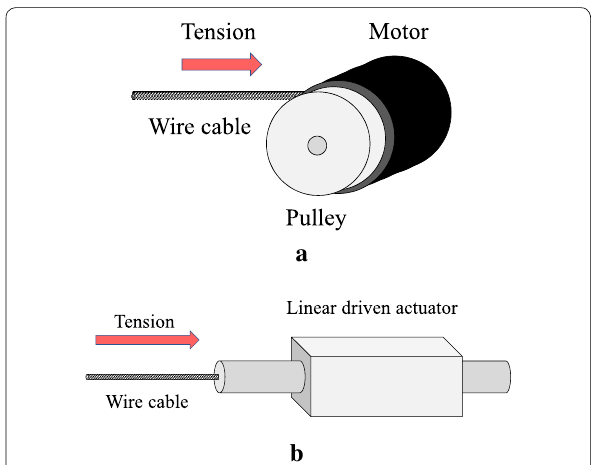
Fig. 2 Model of the mechanical muscle